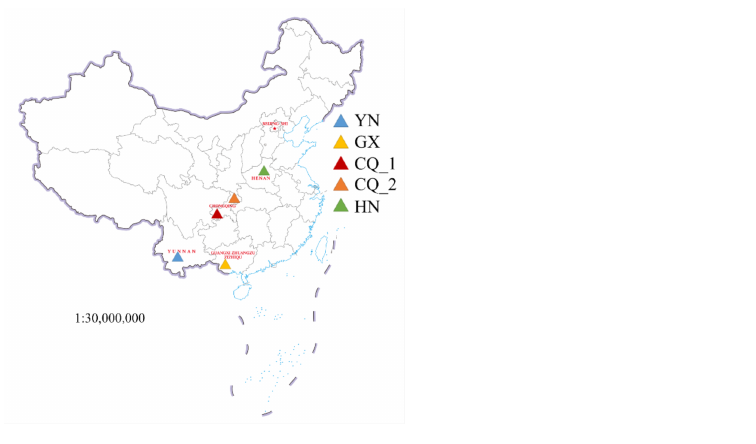
Figure 1. Sampling sites of parasitic flies and Spodoptera. frugiperda in China (Yunnan (YN), Guangxi (GX), Chongqing (CQ_1, CQ-2), and Henan